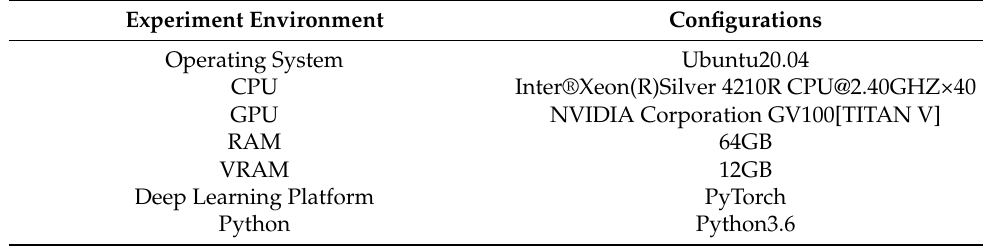
Table 3. Specifications of the experimental